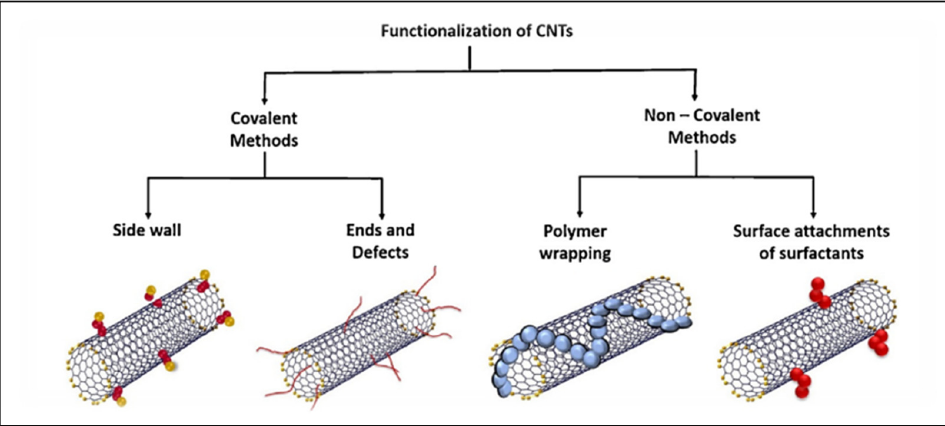
Figure 3. Functionalization methods of carbon nanotubes [99], with permission from Elsevier, 2022.